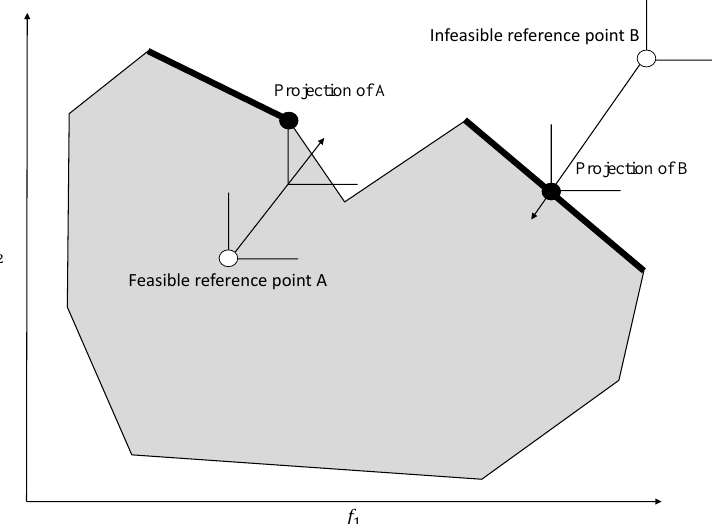
Figure 11. A light beam approach integrated within an EMO that finds a crowded set of points close to the Pareto-frontier based on the aspirations of the DM.